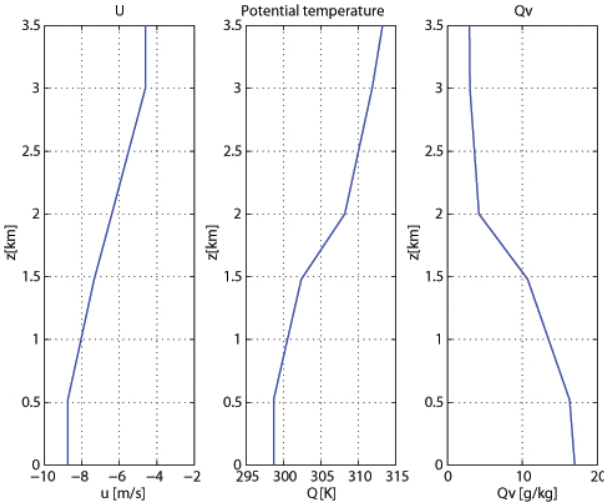
Fig. 3. Initial environmental profiles for the BOMEX